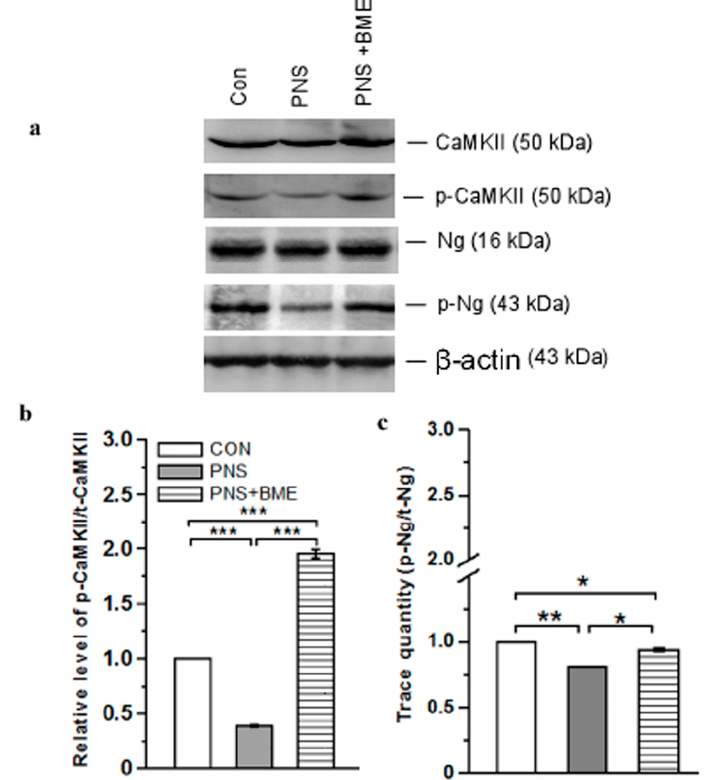
Figure 9. Exposure to BME treatment protects against PNS-induced changes in the activation of CaMKII. ( a ) Representative Western blot showing variations in the level of CaMKII / p-CaMKII and Ng / p-Ng. Estimated ratio of phosphorylation of CaMKII ( b ) and Ng / p-Ng ( c ) in experimental groups. Data are expressed as mean ± SEM ( n = 6 / each group). One-way ANOVA followed by Bonferroni post hoc test (for all pairwise multiple comparisons, statistical significance is indicated by * p < 0.05, ** p < 0.01 and *** p <